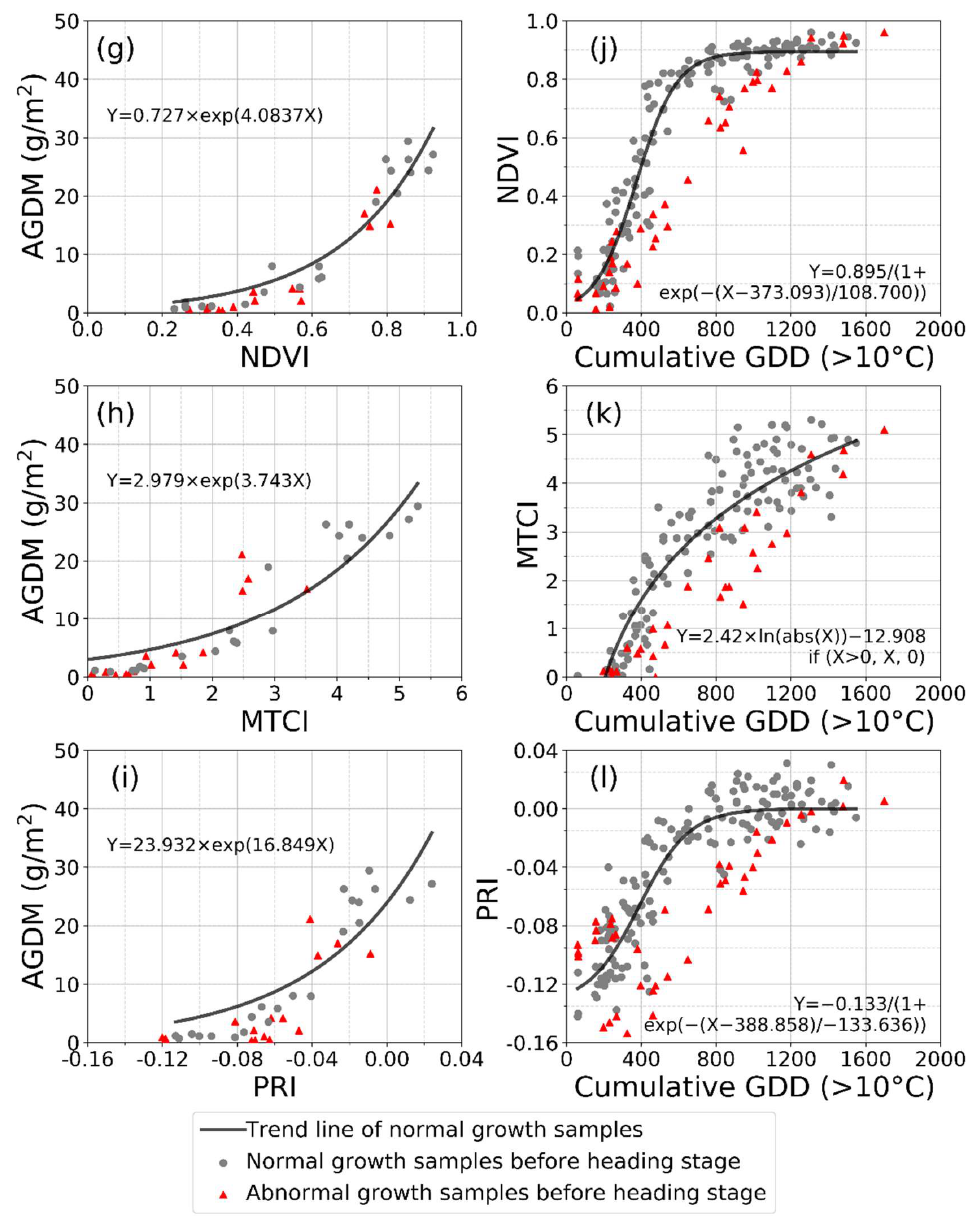
Figure 10. Relationship between vegetation indices and (1) plant height ( a )–( c ); (2) leaf area index (LAI) ( d )–( f ); (3) above-ground dry matter (AGDM) ( g )–( i ); (4) cumulative growing degree days (GDD) ( j )–( l ).